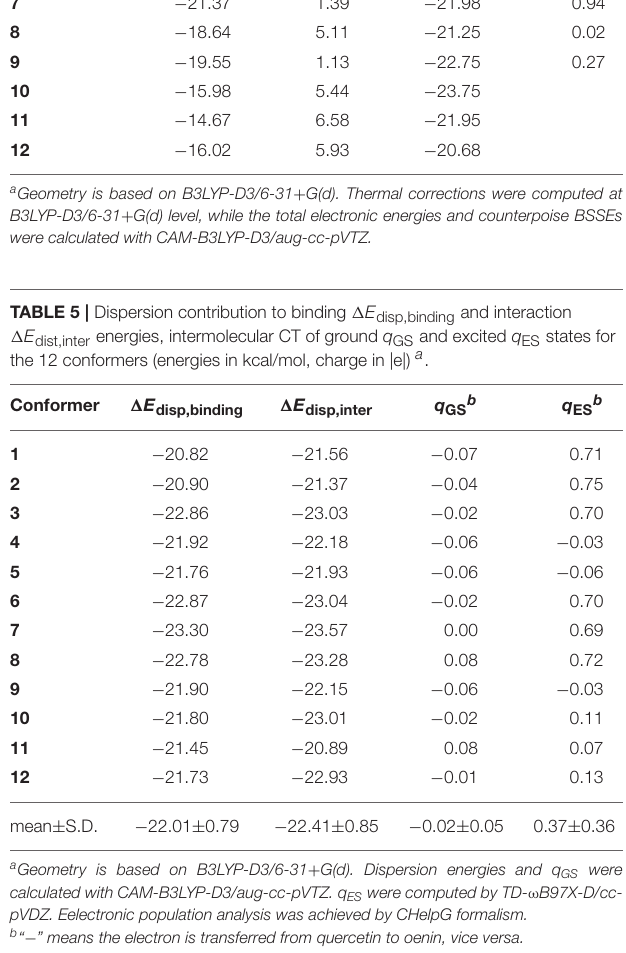
TABLE 4 | Binding energies 1 E binding , distortion energies 1 E dist , interaction energies 1 E inter , and Boltzmann weights BW (in kcal/mol) a . Conformer